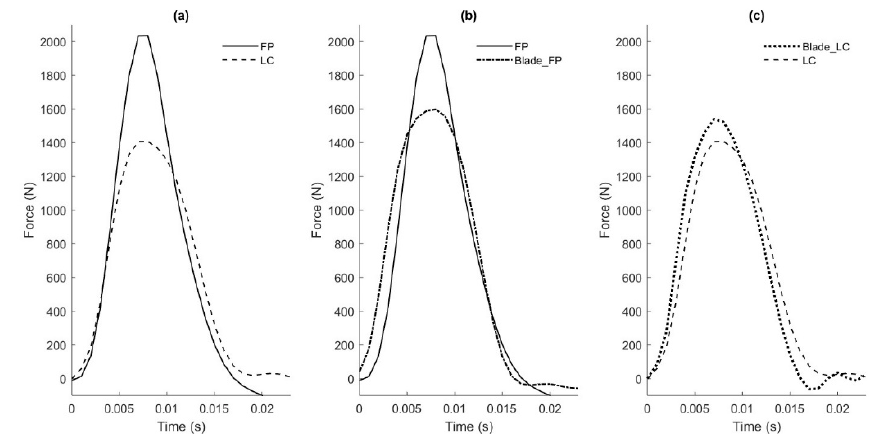
Figure 6. Comparison of force plate (FP) force, load cell (LC) force, blade force from FP calibration (BFP), and blade force from LC calibration (BLC) from one representative controlled drop trial. ( a ) FP and LC forces from the same drop trial, demonstrating the large difference between peak magnitudes; ( b ) FP and BFP forces, showing similarly large differences in peak magnitudes; ( c ) LC and BLC forces, showing better agreement in peak magnitudes.